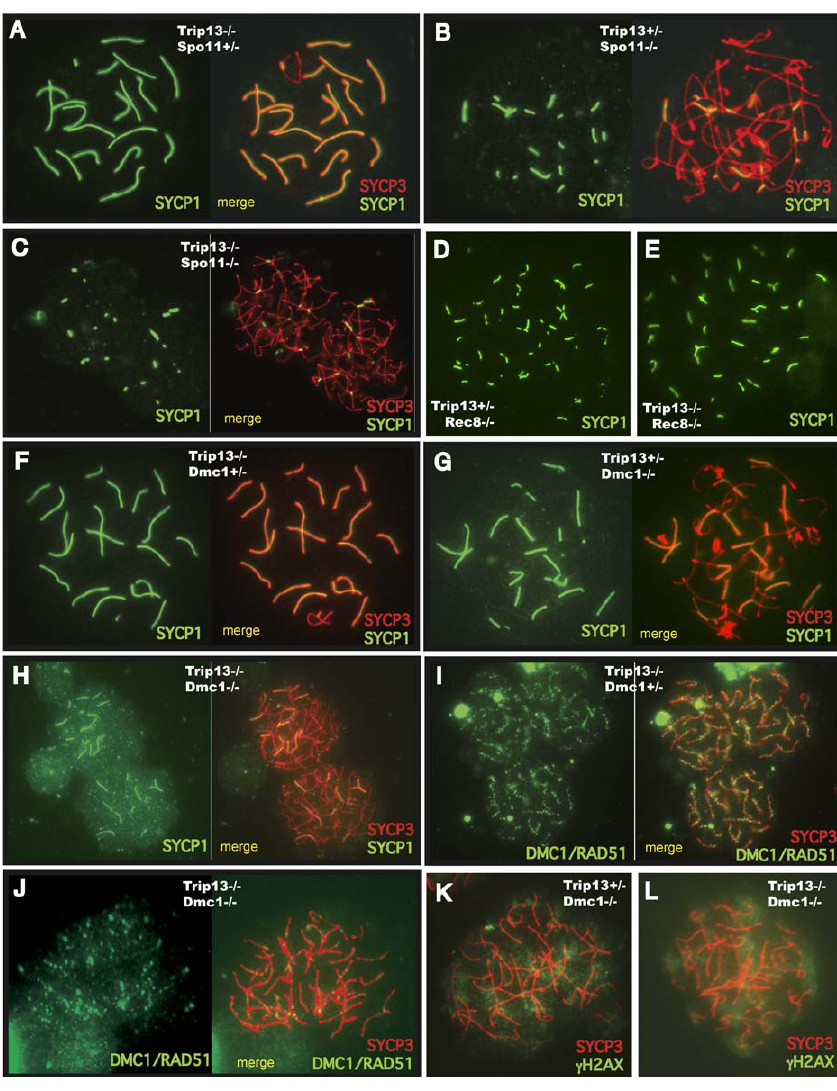
Figure 5. Immunocytological Analysis of Trip13 Compound Mutants Surface-spread chromosomes were immunolabeled with the indicated antibodies and fluorophores. Genotypes are indicated, as are those panels in which dual staining patterns are merged. Note that (H) and (I) are at lower magnification to show multiple nuclei. Dmc1 . As in Dmc1 (cid:2) / (cid:2) mice, in which spermatocytes undergo meiotic arrest from defective DSB repair and failed chromo- some synapsis [16], spermatogenesis in Dmc1 (cid:2) / (cid:2) Trip13 Gt/Gt testes was uniformly arrested at the point where spermato- cytes contained chromatin characteristic of zygonema/pachy- nema (Figure 3N). Immunocytological analysis indicated that both Dmc1 (cid:2) / (cid:2) and Dmc1 (cid:2) / (cid:2) Trip13 Gt/Gt chromosomes had extensive asynapsis compared to Trip13 Gt single mutants (Figure 5F–5H), and all had persistent RAD51/DMC1 foci and phosphorylated H2AX ( c H2AX; Figure 5I–5L), confirming that Dmc1 is epistatic to Trip13 . Doubly mutant females had residual ovaries, phenocopying Dmc1 (cid:2) / (cid:2) and Trip13 Gt/Gt single mutants (unpublished data).